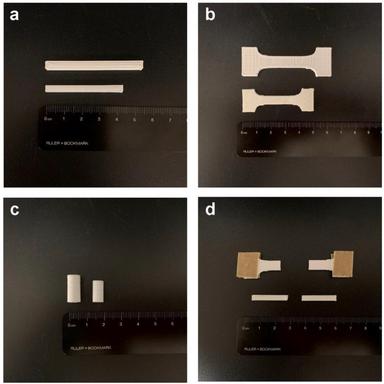
Specimens for mechanical testing (a) three-point bending test specimens before (top) and after sintering (bottom) (b) tensile test specimens before (top) and after sintering (bottom) (c) compression test specimens before (left) and after sintering (right) (d) fractured specimens for the tensile test (top) and bending test (bottom).